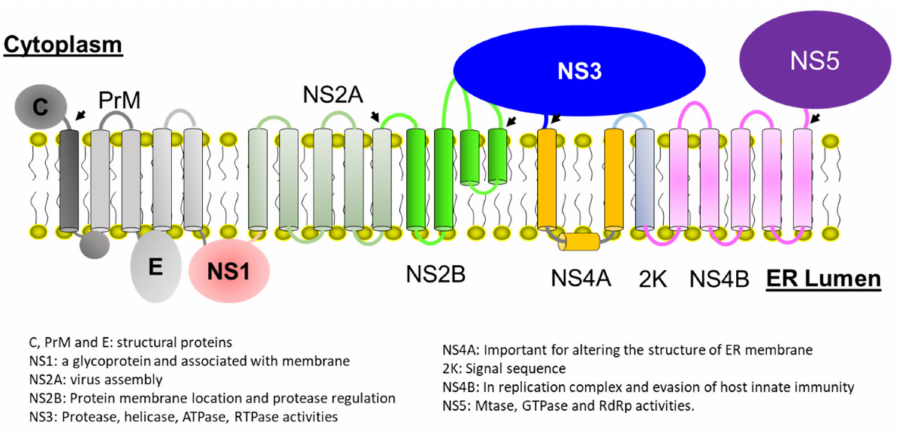
Figure 1. A schematic plot of Zika polyprotein on the membrane of the endoplasmic reticulum. Arrows indicate the viral protease cleavage sites. The cell membrane and membrane topology of viral proteins are listed. The possible transmembrane helices are indicated as cylinders. Different viral proteins are indicated in different color. The figure was made based on the previous report [33] and permission was obtained. For the detailed function of viral proteins, please refer to other references